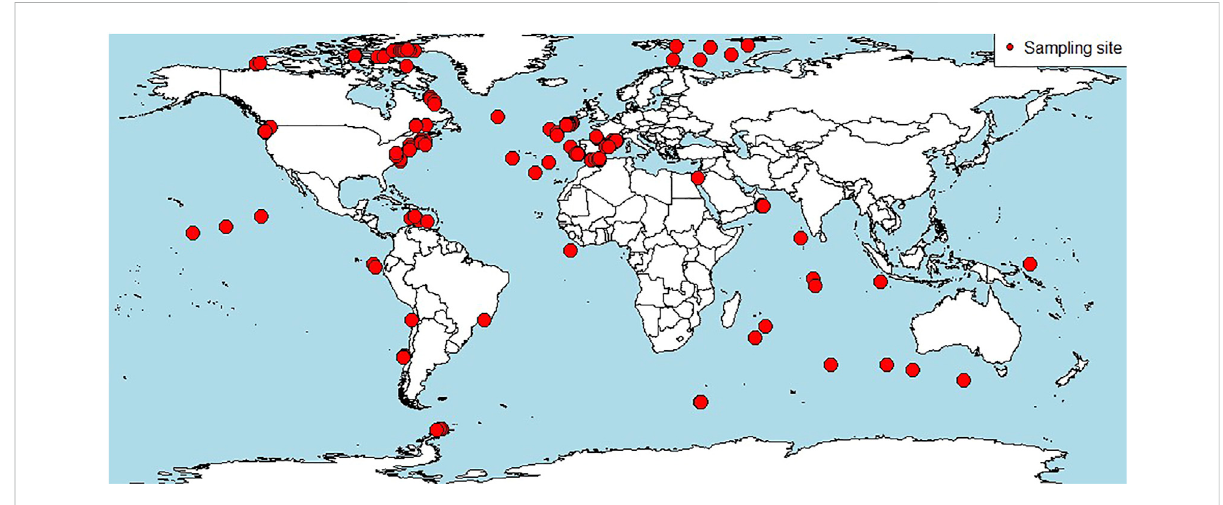
FIGURE 2 Localities of sampling sites in the